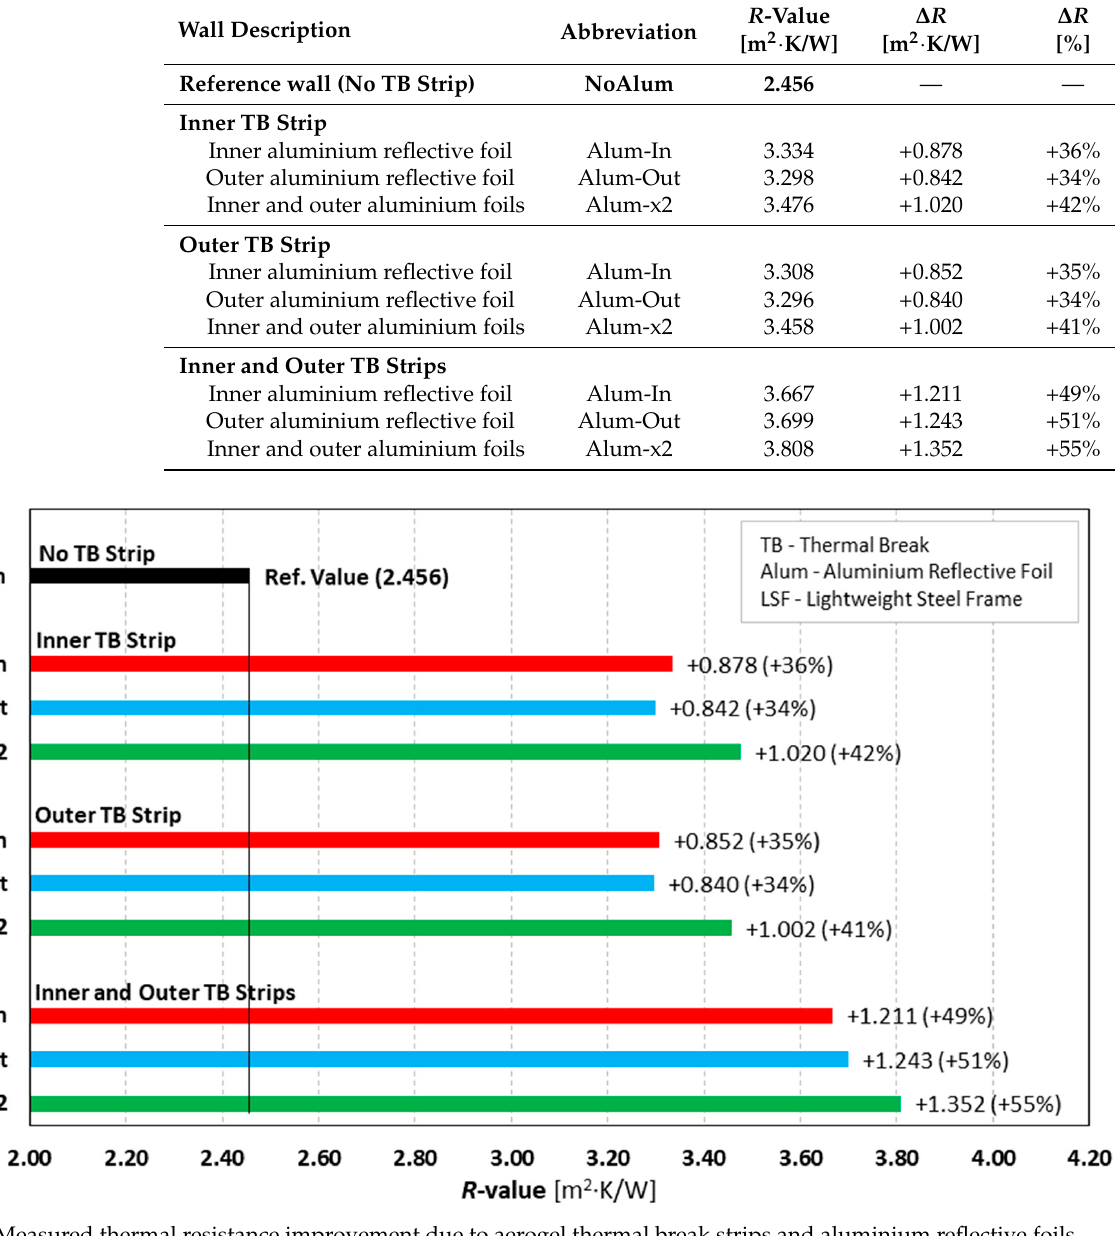
Figure 8. Measured thermal resistance improvement due to aerogel thermal break strips and aluminium reflective foils. Table 6. Measured thermal resistance of double-pane LSF walls and thermal performance improvement due to aerogel thermal break strips and aluminium reflective foils.